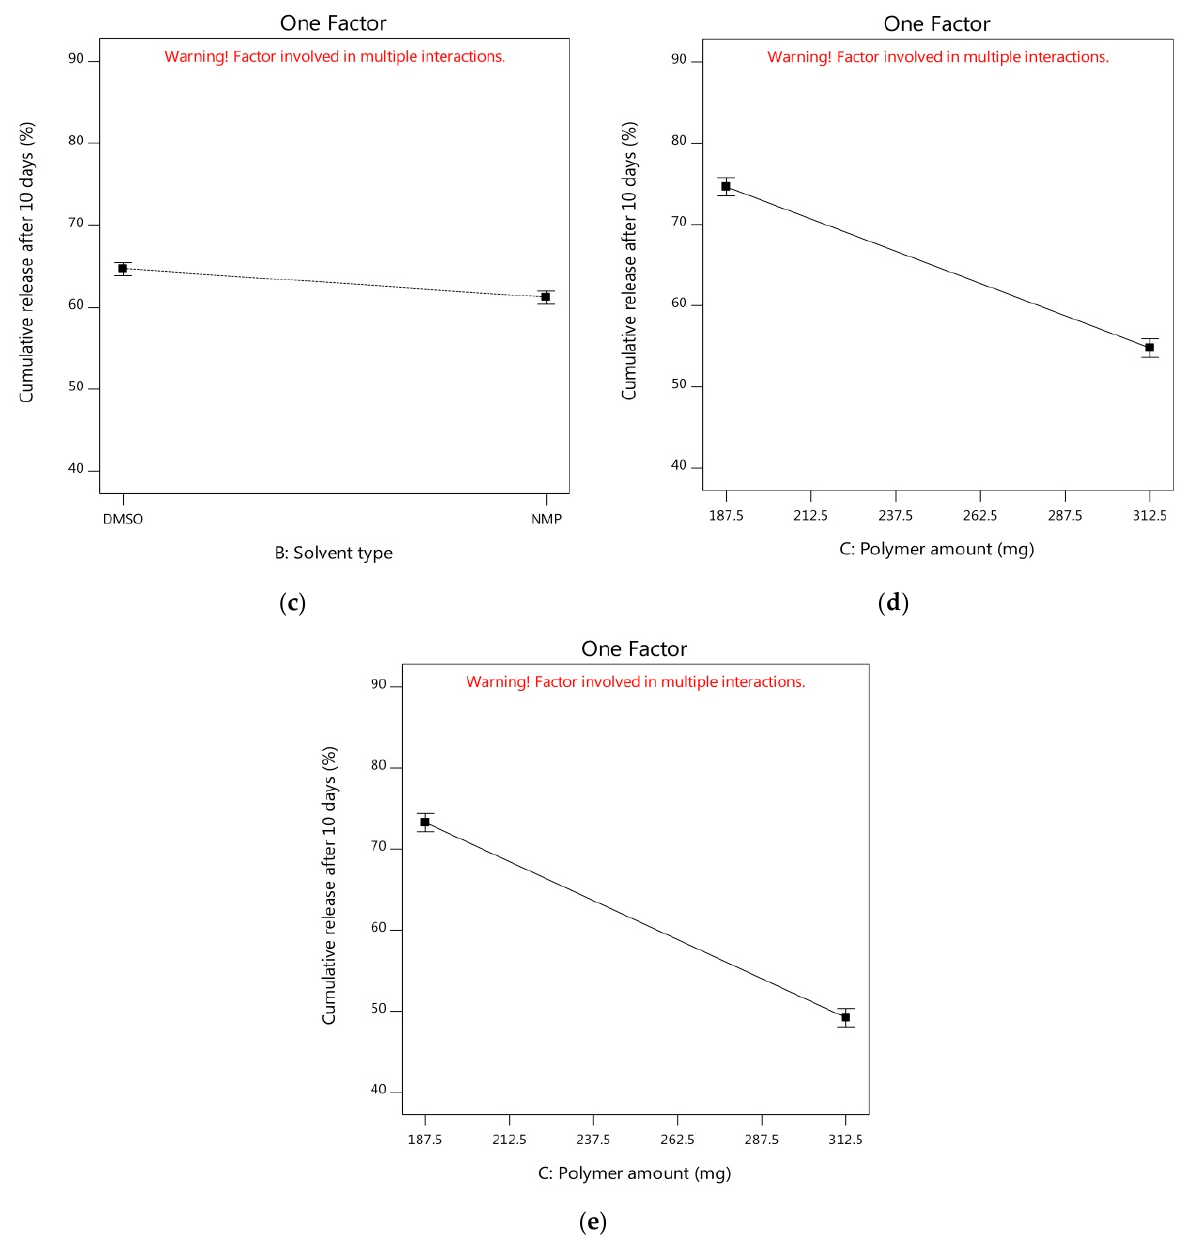
Figure 5. One factor plots of influence of independent factors on Y 2 response ( a ) effect of A using DMSO and medium level of C ( b ) effect of A using NMP and medium level of C ( c ) effect of B using medium levels of A and C ( d ) effect of C using DMSO and medium level of A ( e ) effect of C using NMP and medium level of A.